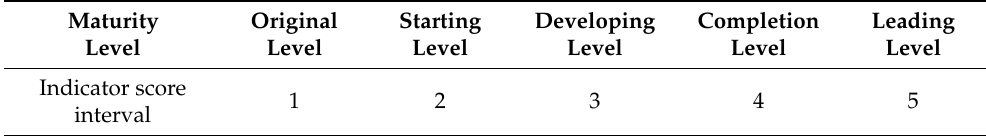
Table 3. Maturity Stage Corresponding to Index Score.